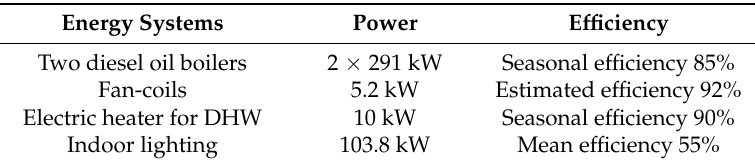
Table 1. Main characteristics of the energy systems.